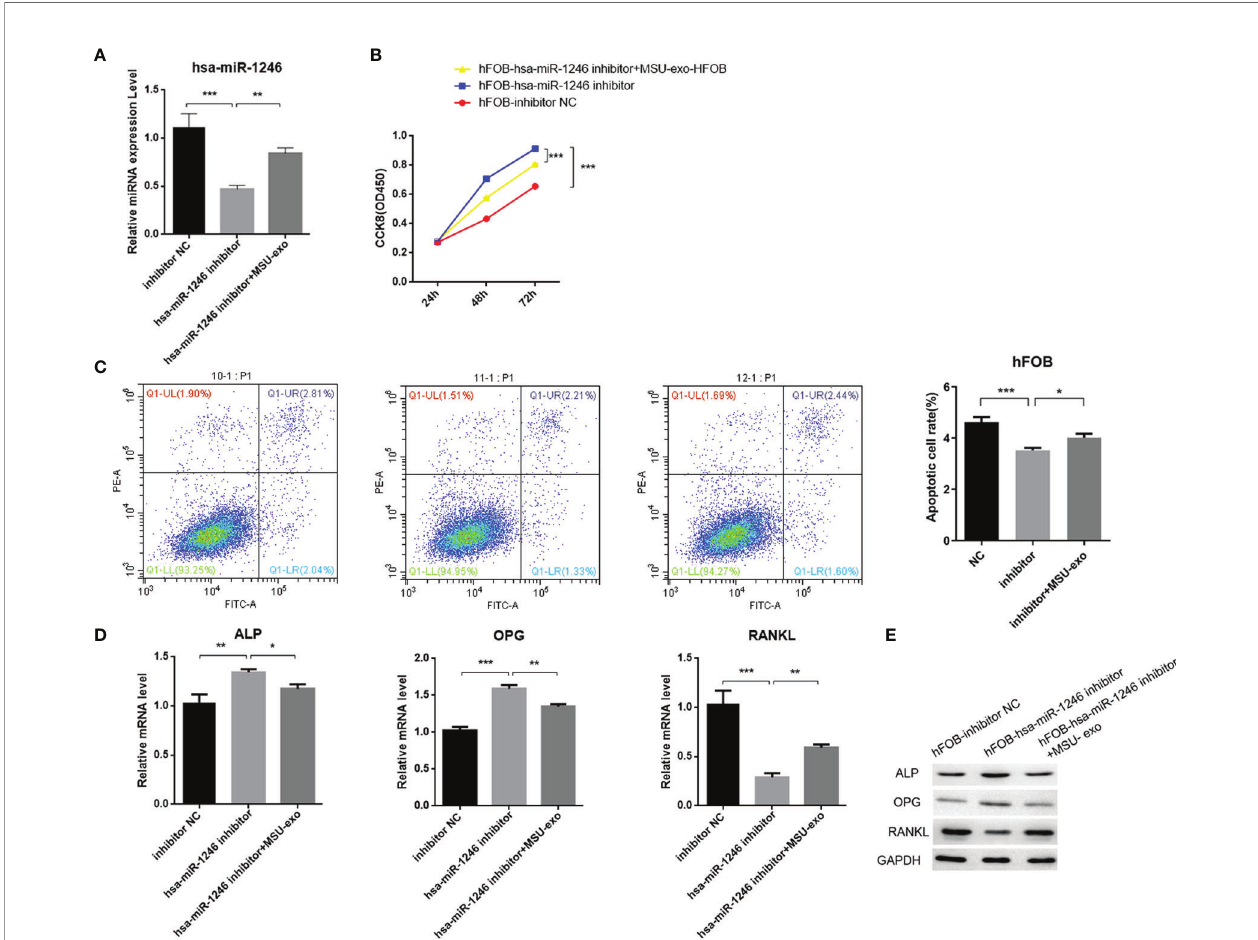
FIGURE 9 | The effect of neutrophil-derived exosomes stimulated by MSU on viability of hFOB (A) Transfection of hFOB with miRNA inhibitors. Interfering fragments are veri fi ed by qPCR. (B) CCK8 assay to exam the cell viability. (C) Flow cytometric analyses to detect the percentages of apoptotic cells. (D) QPCR to detect the expression levels of ALP, OPG, and RANKL. (E) Western blot analysis to determine the expression levels of ALP, OPG, and RANKL (P < 0.05 *, P < 0.01 **, P < 0.001